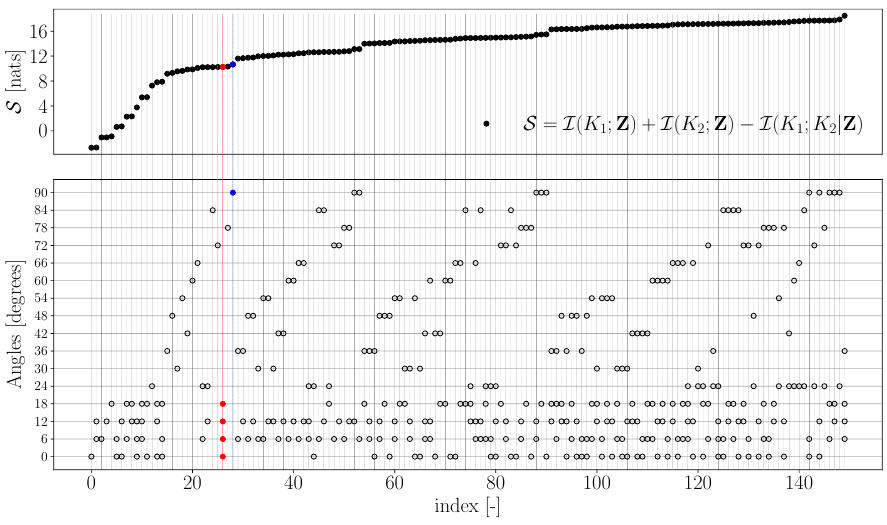
= ( K ) + ( K ) ( K ) across the 2 ; Z 1 ; Z 1 ; K 2 | Z S I I − I . S